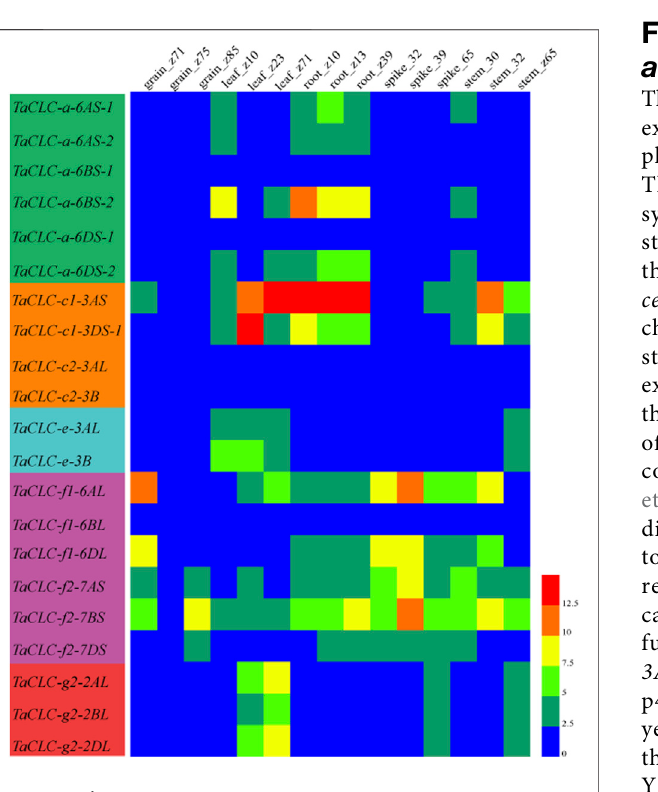
from 12 to 24 h.